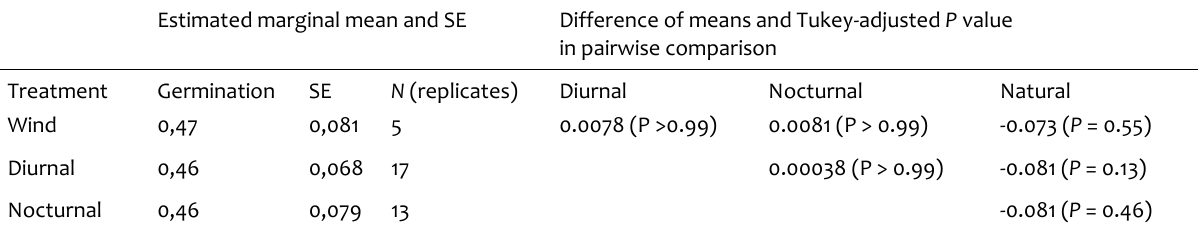
Table 2. Seed germination rate of Salix caprea in different pollination treatments. Marginal (model-adjusted) mean values indicate the back-transformed proportions of germinated seeds per replicate. The right-half is a matrix representation of tests for difference of means in pairwise comparisons. Tukey-adjusted P values are shown in